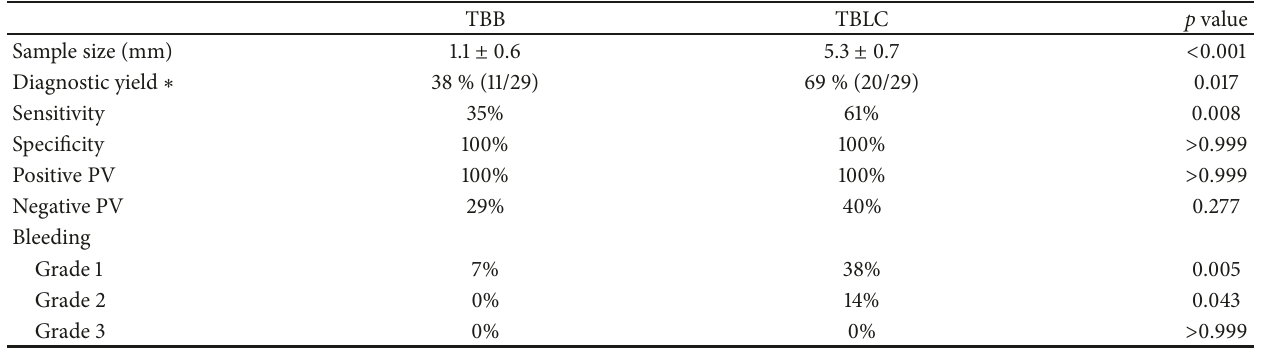
Table 2: Comparison between TBB and TBLC in 29 patients in whom both TBLC and TBB were obtained.